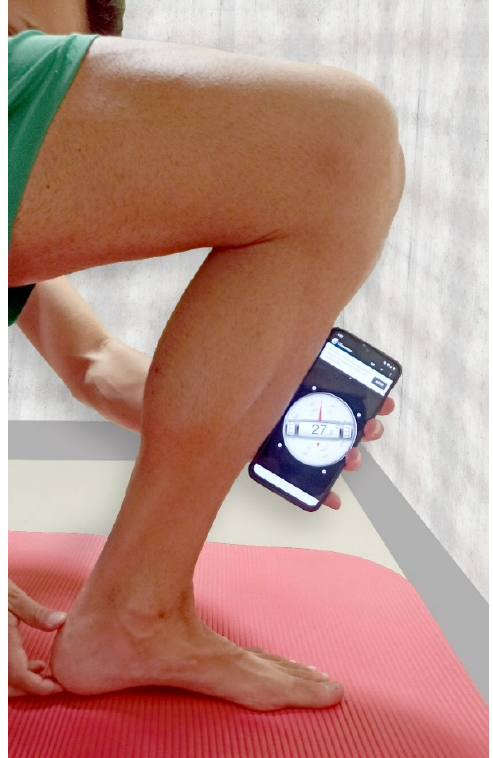
Figure 4. The lunge test was used to measure the ankle dorsiflexion range. A dynamometer (MicroFET2, Hoggan Scientific, Salt Lake City, UT, USA) was used for isometric muscle strength testing. All participants were barefoot during the test.